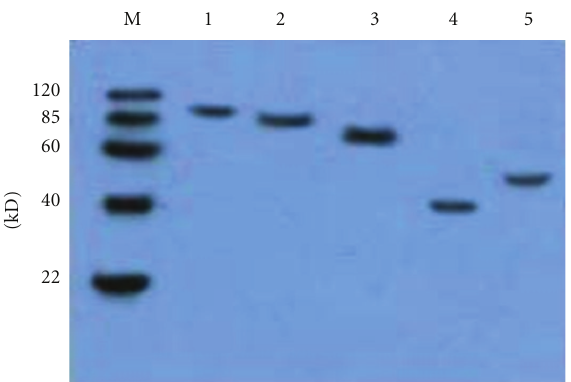
Figure 2: Western blotting results of the five parent proteins to the antibodies against the peptides-BSA, respectively. (1) gB2, (2) gC2, (3) gE2, (4) gG2, (5)